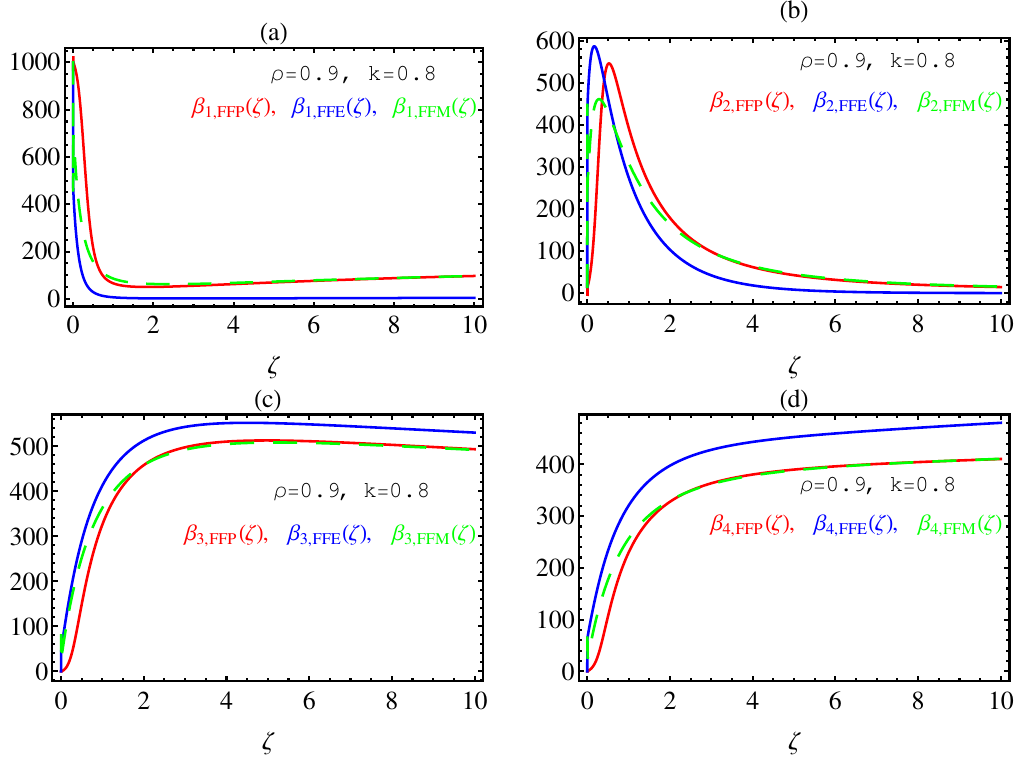
Figure 5. Graph of the combined numerical solutions based on FFP, FFE and FFM for ( a ) β 1 ( ζ ) , ( b ) β 2 ( ζ ) , ( c ) β 3 ( ζ ) and ( d ) β 4 ( ζ ) , respectively, with ρ = 0.9, k = 0.8, λ = 0.01, s = 0.02, δ = 0.6, α = 0.4, β = 0.01, N = 1000, h = 0.0025 and the following initial conditions: β 1 ( 0 ) = 1000, β 2 ( 0 ) = 15, β 3 ( 0 ) = 0and β 4 ( 0 ) = 0. (Red solid color: Numerical solutions (20); Blue solid color: Numerical solutions (33); Green dashed color: Numerical solutions